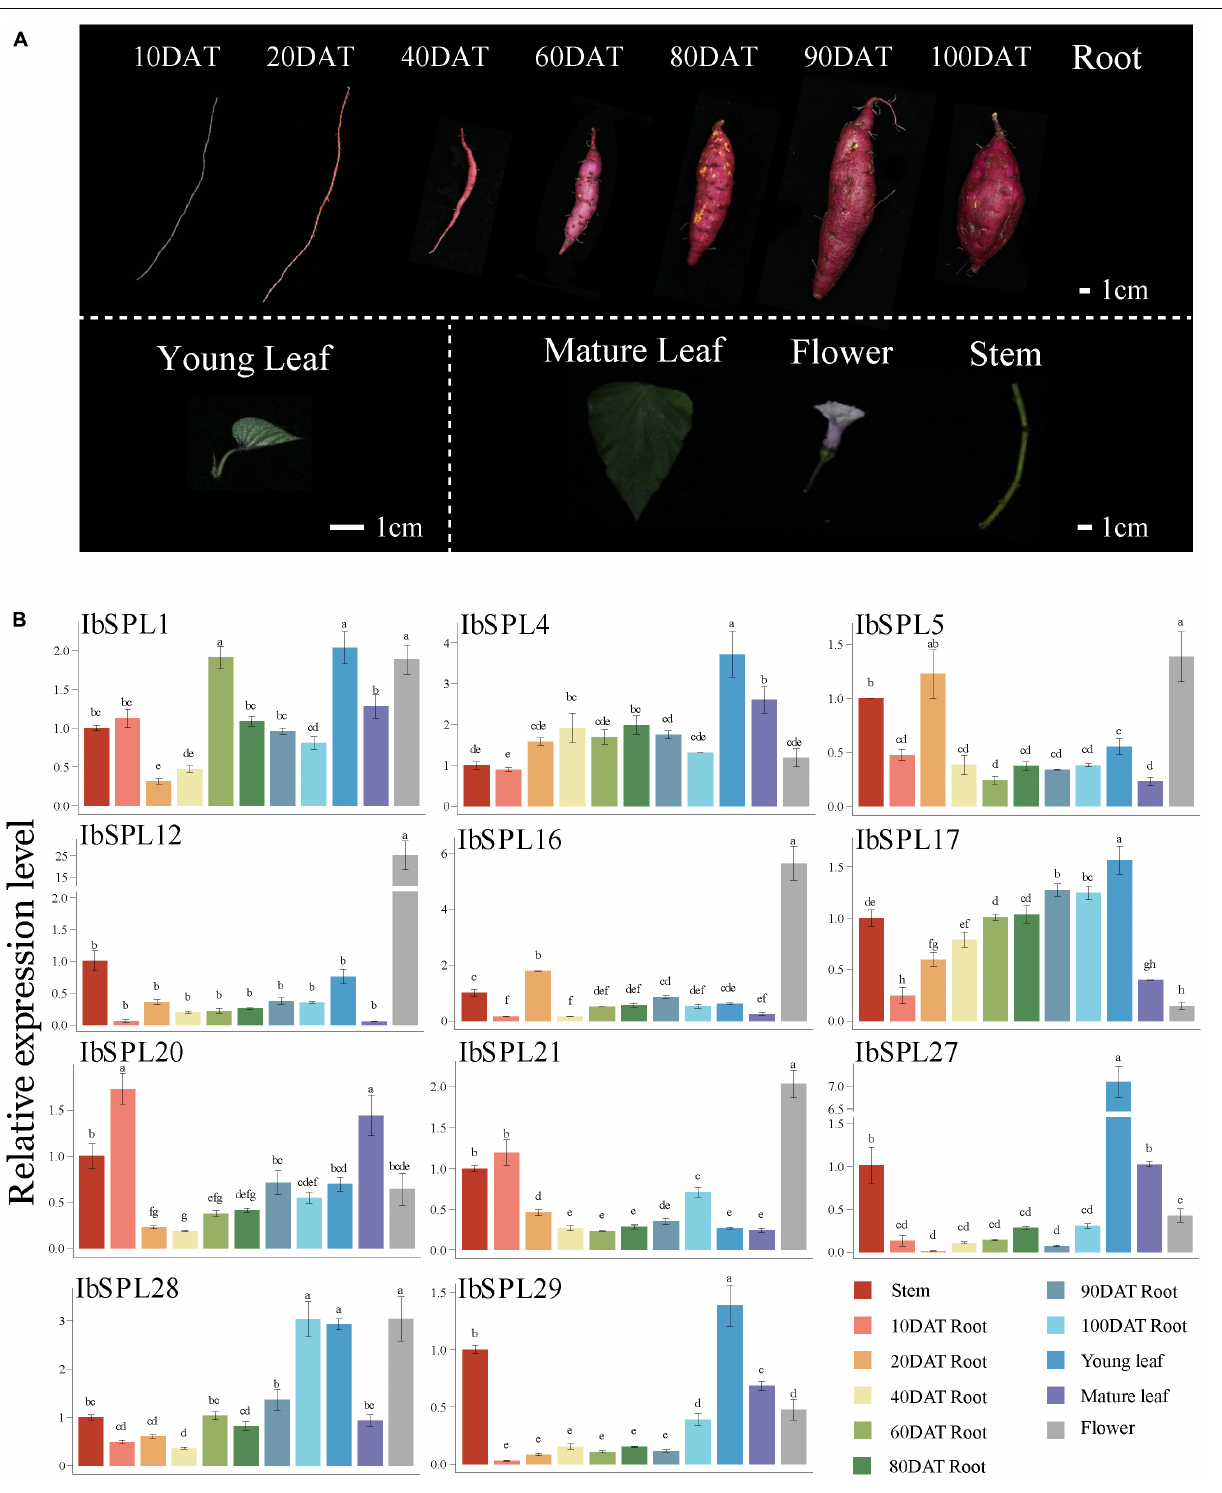
Frontiers in Plant Science |